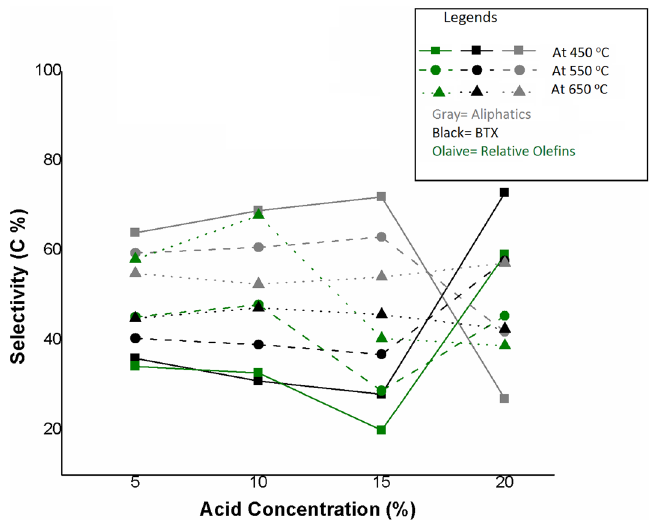
Figure 6. Effect of acid concentration on the selectivity of products for catalytic cracking of n-hexane over H-MCM-22 at different reaction temperatures of 450 °C, 550 °C, and 650